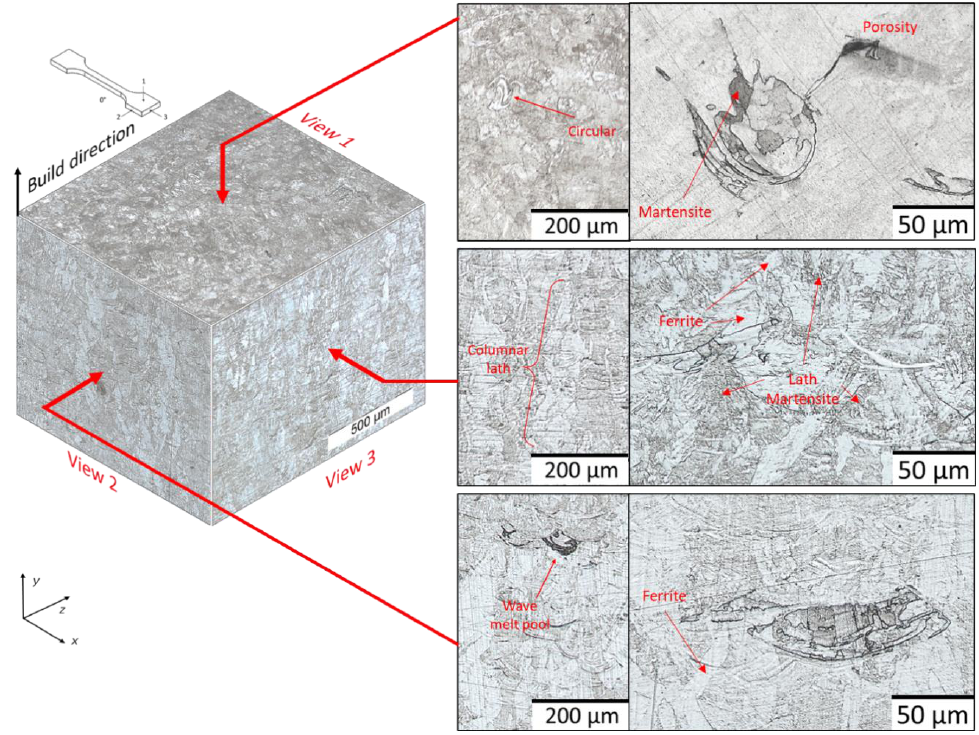
Figure 7. Microstructure profile for 0° build direction.